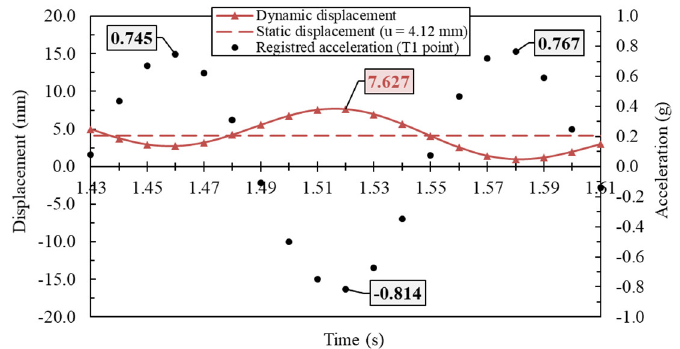
Figure 11. Selection criterium for a real displacement.